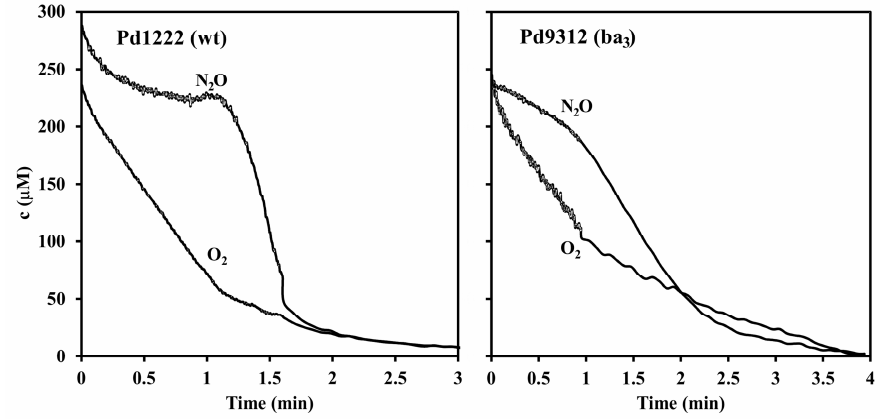
Figure 4. Kinetics of O 2 and N 2 O respiration in wild-type and ba 3 single-route strain of P. denitrificans . O 2 and N 2 O concentrations were monitored by MIMS at m / z 32 and 30 respectively. The measuring chamber was filled up with 5 mL of 0.1 M sodium phosphate pH 7.3, containing 5 mM sodium succinate, 0.24 mM O 2 and 0.24 mM N 2 O. The experiment was started by the addition of anaerobically grown cells (5 mg dry weight) at zero time. Microorganisms 2020 , 8 , x FOR PEER REVIEW